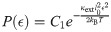
Straining of crosslinkers and energy storage.(A-C) Probability density distribution (PDF) of the extensional strains (top) and torsional strains (bottom) of crosslinkers with various stiffness values as indicated above the figure, at the end of individual simulations (t = 50s). For comparison, red lines indicate the corresponding Boltzmann distributions of a free spring with the same stiffness, P(ϵ)=C1e-κextl02ϵ22kBT and P(θ)=C2sinθe-κtorθ22kBT, where C1 and C2 are the normalization constants for ϵ ∈ (−1, ∞) and θ ∈ (0, π) respectively. Note that for the extensional strain, when we calculate the Boltzmann distribution, the energy contribution from steric interactions, which lead to the empty region at highly negative strains in the histogram, is neglected. (D, E) Average absolute value of the extensional strain ϵ (D) and the corresponding extensional energy Eext (E) as a function of the extensional stiffness κext. (F, G) Average torsional strain θ (F) and the corresponding torsional energy Etor (G) as a function of the torsional stiffness κtor. In (D-G), simulations are performed for filaments of various lengths: 81nm (blue), 135nm (red), and 189nm (orange). For each simulation, the means of the energy were calculated from the data between 40s to 50s and the error bars indicate standard deviation over 10 simulations. Energies corresponding to the networks in panels (A-C) are identified by the red symbols with corresponding shapes.